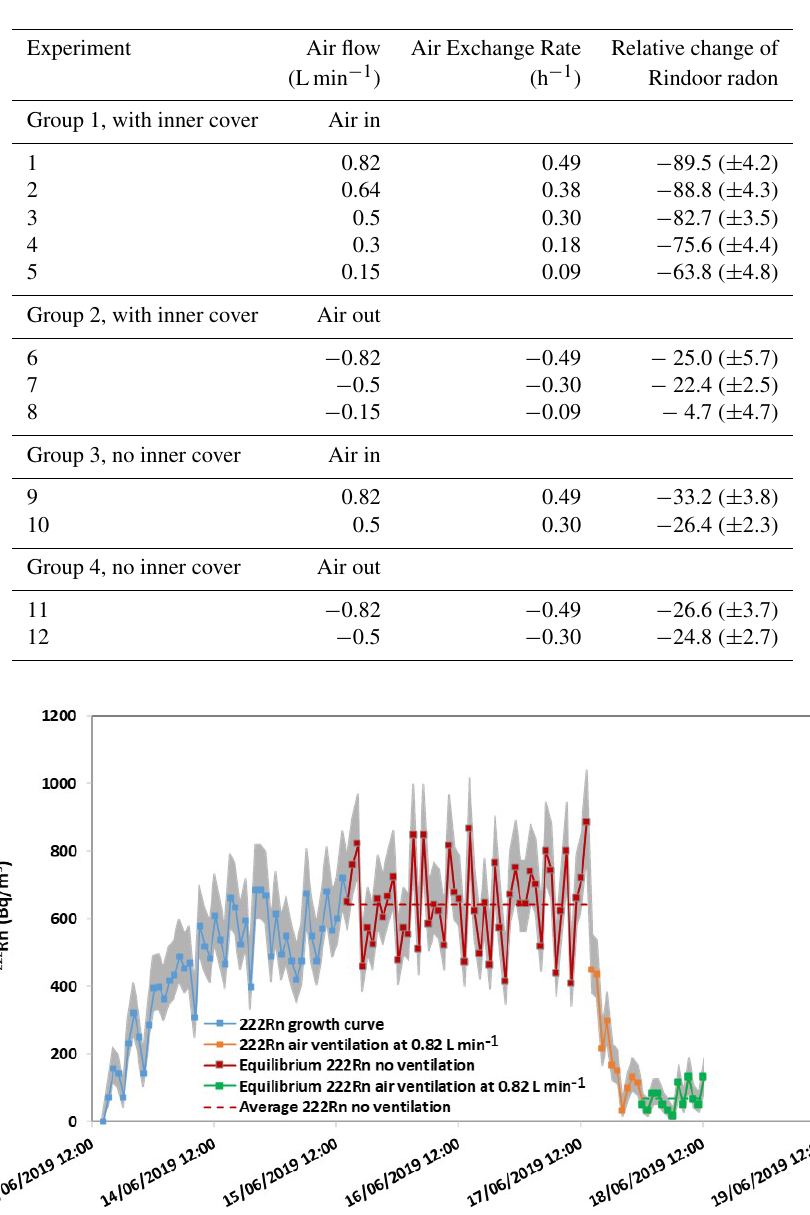
Figure 2. 222 Rn activity concentration versus time during experiment 1 (first group of experiments). Radon data were recorded hourly. The relative standard deviation is about 40% at 100Bqm − 3 , about 18% at 500Bqm − 3 and about 13% at 1000Bqm − 3 . The grey band shows data uncertainties (one standard